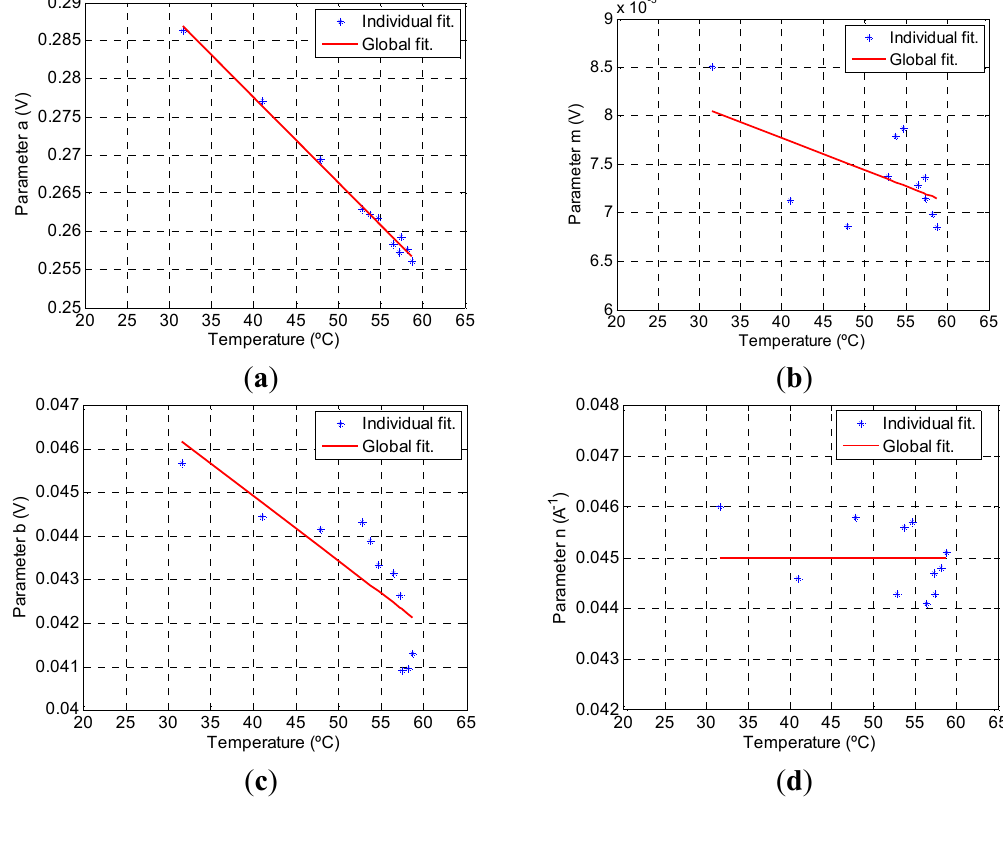
Figure 5. Results of the individual fit for each temperature and the global fit for the activation parameters ( a , c ) and concentration parameters ( b , d ) for the FC electrical model for a temperature range of 20 to 62 °C. Individual fit. Global fit. Individual fit. Global fit.